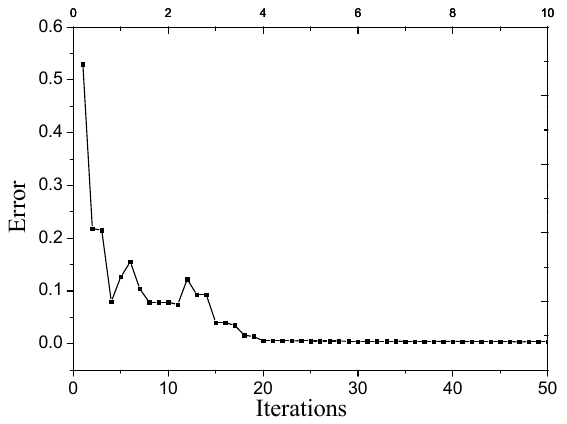
Figure 3. Optimal solution and performance tracking after 50 iterations. Table 3. Identification results of kinetic parameters of solid-phase lithium ion diffusion.